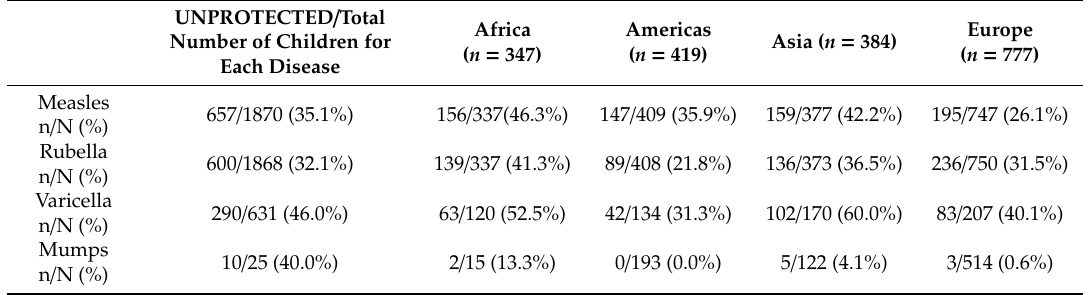
Table 3. Percentage of children in the study with unprotective antibody titers (seronegative) against measles, rubella, varicella, and mumps, by continent of